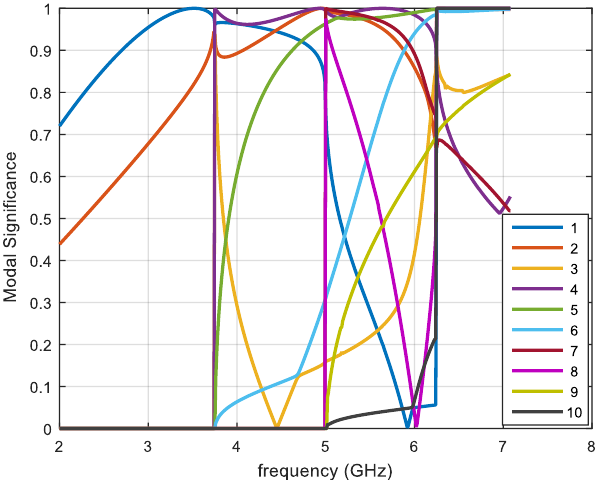
Figure 3: The modal significance values for rectangle patch inside 15 x 15 mm square unit cell.